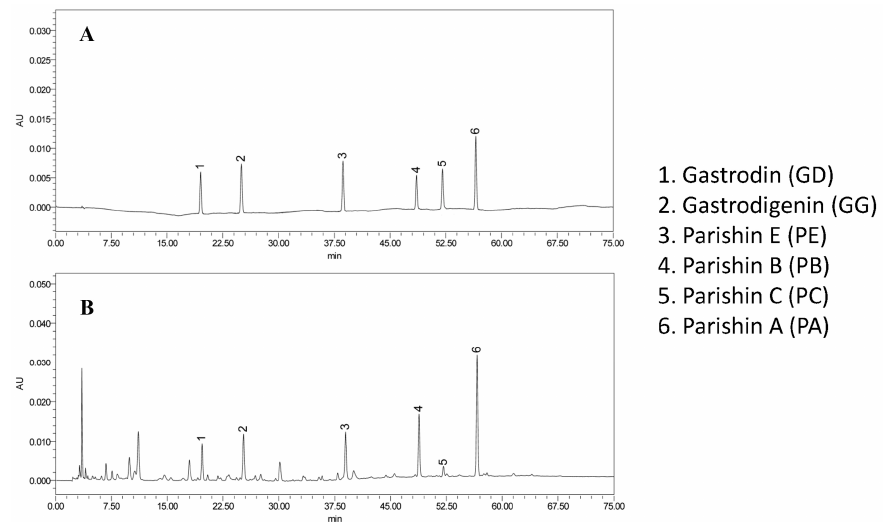
Figure 2. HPLC chromatograms of gastrodin-type components in ( A ) standard solution and ( B ) sample solution. Table 2. RSD of precision, stability, repeatability and accuracy for determination of six gastrodin-type components.